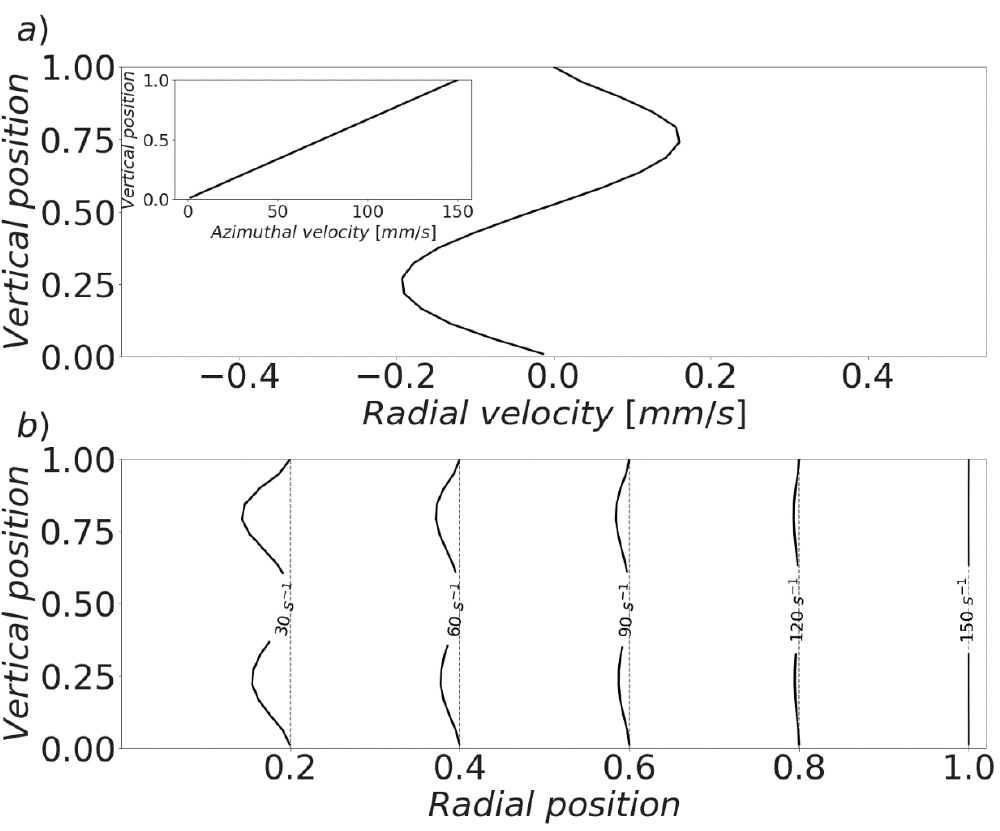
Figure 7. Local velocity and shear rate profiles in a parallel plates geometry. The rotating plate is located at the top. ( a ) Primary (azimuthal, inset) and secondary (radial) velocity profiles at the edge of the geometry. ( b ) Shear rate profile. The center of the geometry is located at the left. The vertical dashed lines correspond to the ideal design scenario (no secondary flow).